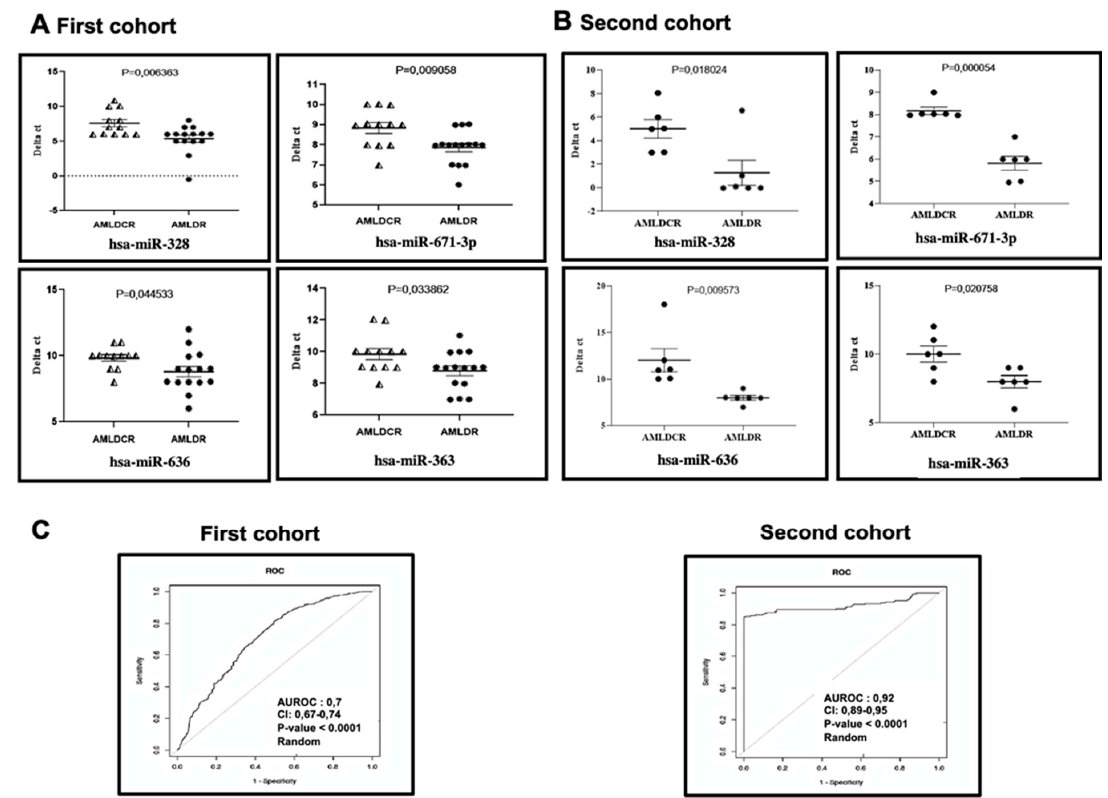
Figure 4. Prognosis value of AML bone marrow circulating miRNAs. The expression dot blot and receiver operating characteristic (ROC) curves reflecting the representative bone marrow circulating miRNAs (4 miRNAs) differentially expressed between the AML patients based on their overall survival at diagnosis ( A ) and validated in an independent second cohort of patients ( B ). ( C ) Receiver Operating Characteristic (ROC) plot validating the combined prognosis power of miR-671-3p and miR-328 in the first and second cohorts. AMLDCR: AML at diagnosis samples in which the patients have complete remission 4 years post diagnosis. AMLDR: AML at diagnosis samples in which the patients relapsed and died during the 4 years post diagnosis.